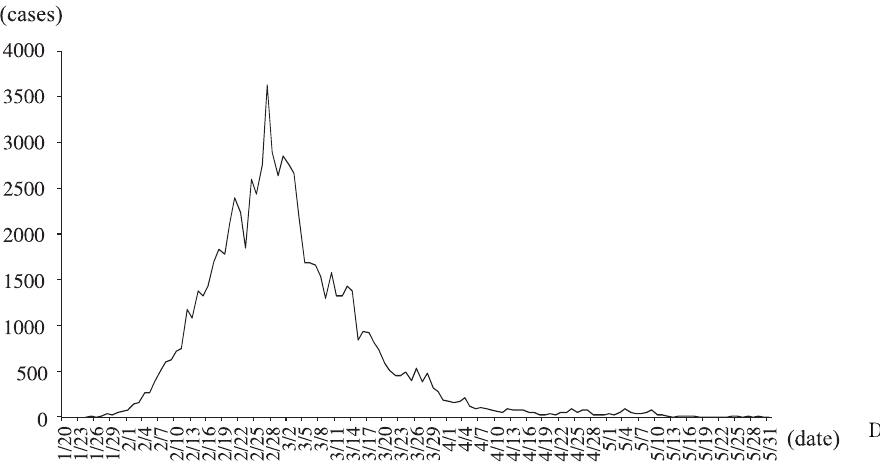
Figure 4. Daily Figure for